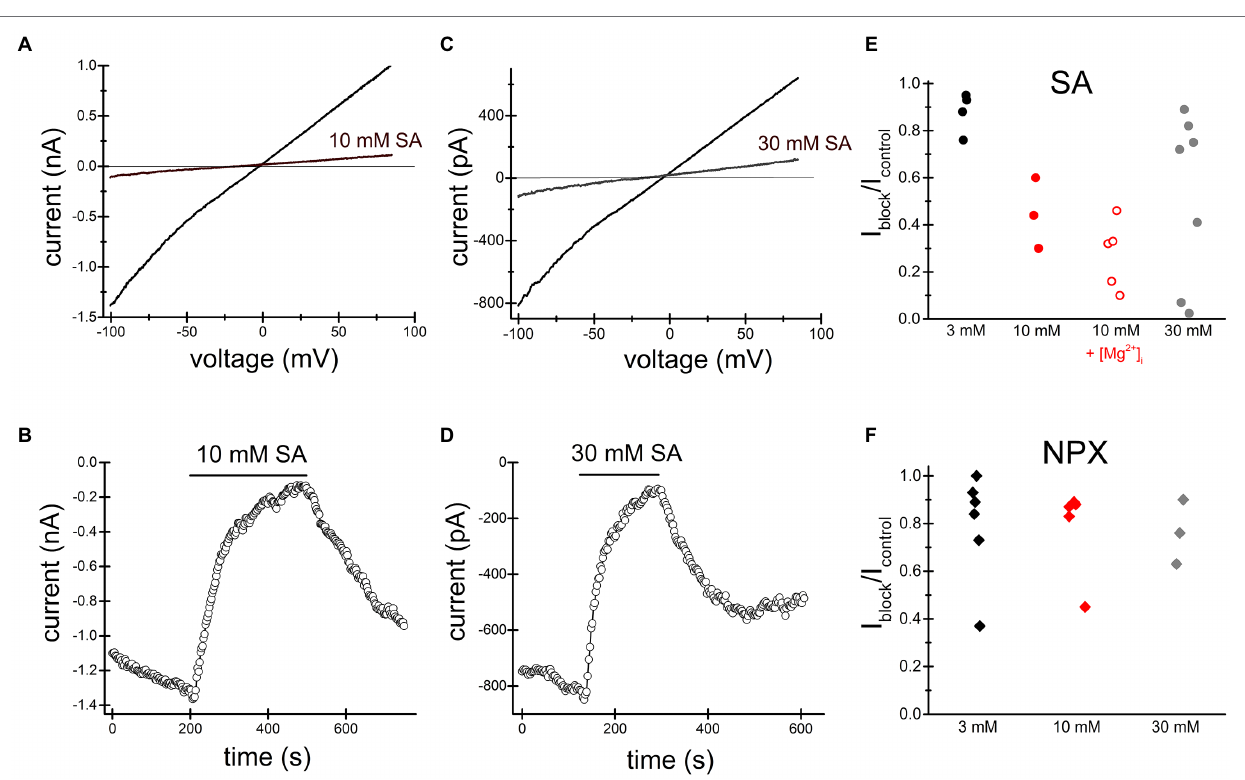
FIGURE 2 | Salicylate inhibits TRPM7 current. Summary of naproxen and salicylate inhibition of TRPM7 current at various concentrations. TRPM7 monovalent I–V relations obtained in the absence and presence of 10 mM (A) and 30 mM (C) salicylate. (B,D) show the corresponding time course of salicylate inhibition. Representative recordings from n = 3 (A,B) and n = 9 (C,D) Jurkat T cells. Third (A,B) and fourth (C,D) drug applications are depicted. (E) Summary of salicylate effects on TRPM7 current at 3, 10, and 30 mM. Each symbol represents the ratio of current amplitude after inhibition (I block ) to current amplitude before drug application (I control ) in one cell. The internal solution contained 1 mM HEPES. In cells represented by empty red circles, the internal solution was supplemented with 250 μ M MgCl 2 (free [Mg 2+ ] = 134 μ M). (F) Summary of naproxen effects on TRPM7 current at 3, 10, and 30 mM. The internal solution contained 1 mM HEPES and no added Mg 2+ . In (E,F) responses to the second application of the drug are